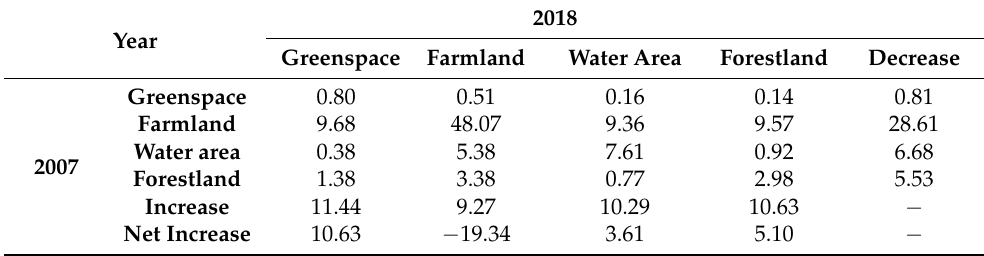
Table 6. GI transformation area (km 2 ) matrix from 2007 to